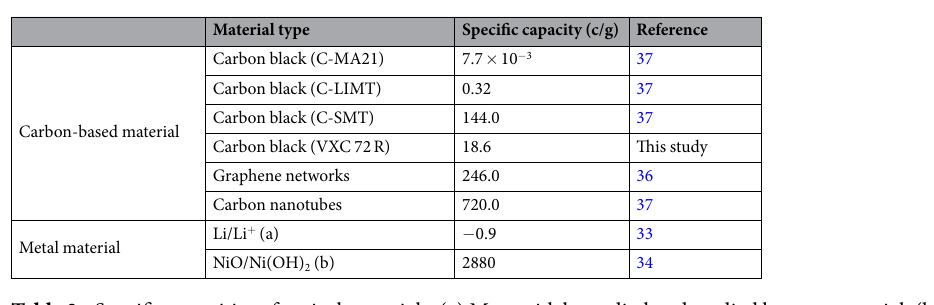
Table 2. Specific capacities of typical materials. (a) Most widely studied and applied battery material. (b) Material with the best-published specific capacity result in the